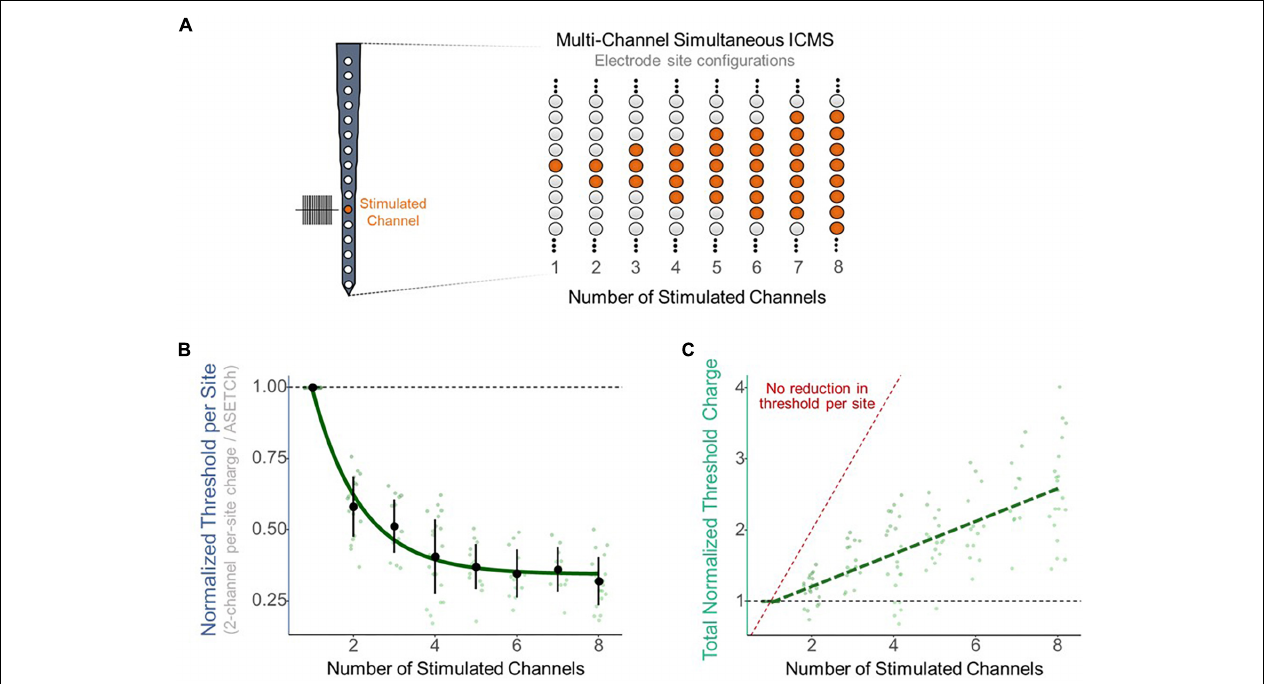
FIGURE 3 | Reduction in per-site threshold charge with multi-site synchronous stimulation. (A) Layout of stimulated electrode sites for multi-site experiments. Primary electrode located 1,150 µ m from the cortical surface. Increasing number of adjacent secondary electrodes stimulated simultaneously for multi-site stimulation. (B) Improvement in per-site threshold charge levels with increasing number of simultaneously stimulated electrode sites. Values were fitted with an exponential decay model (std error = 0.01265). (C) Total charge output by the stimulator with increasing number of simultaneously stimulated electrode sites. Values were fitted with a linear regression model ( R 2 = 0.641). Red dotted line represents expected total charge values if no reduction in threshold occurred (threshold charge with one channel multiplied by the number of channels